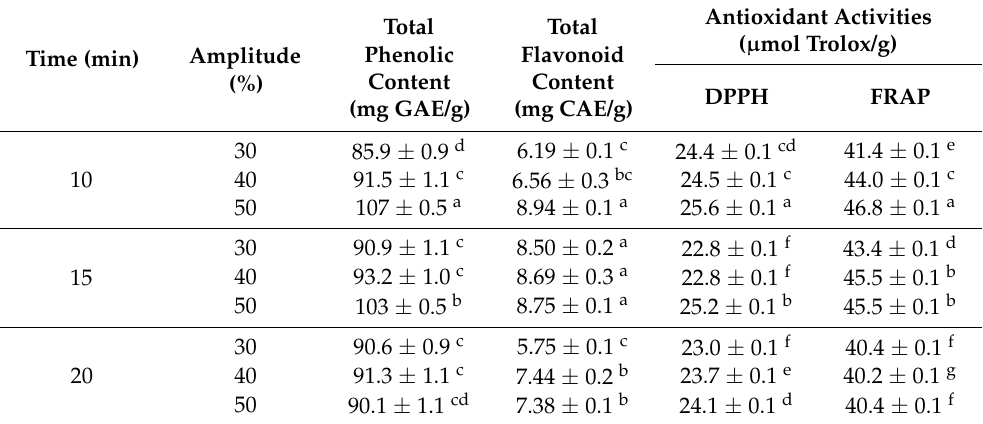
Table 1. Total phenolic (mg GAE/g) and flavonoid (mg CAE/g) content and antioxidant activity based on DPPH and FRAP (%) of ultrasound-assisted green soybean pod extracts as a function of time and the ultrasonic amplitude